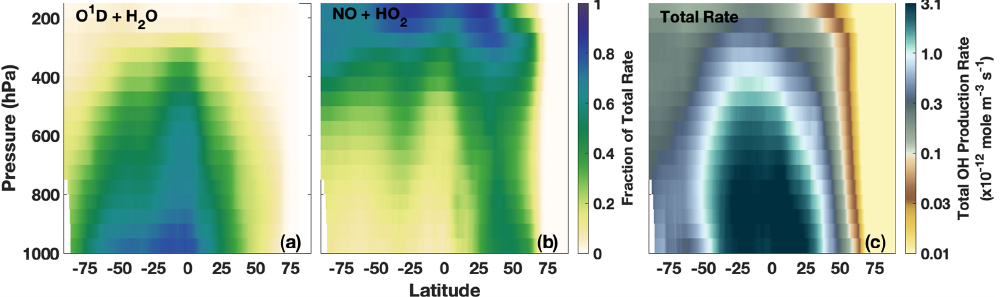
Figure 6. Zonal mean of the fractional contribution of the O 1 D + H 2 O (a) and NO + HO 2 (b) reactions to the total OH production rate and the total OH production rate (c) for El Niño events (MEI > 0.5) for DJF, averaged over